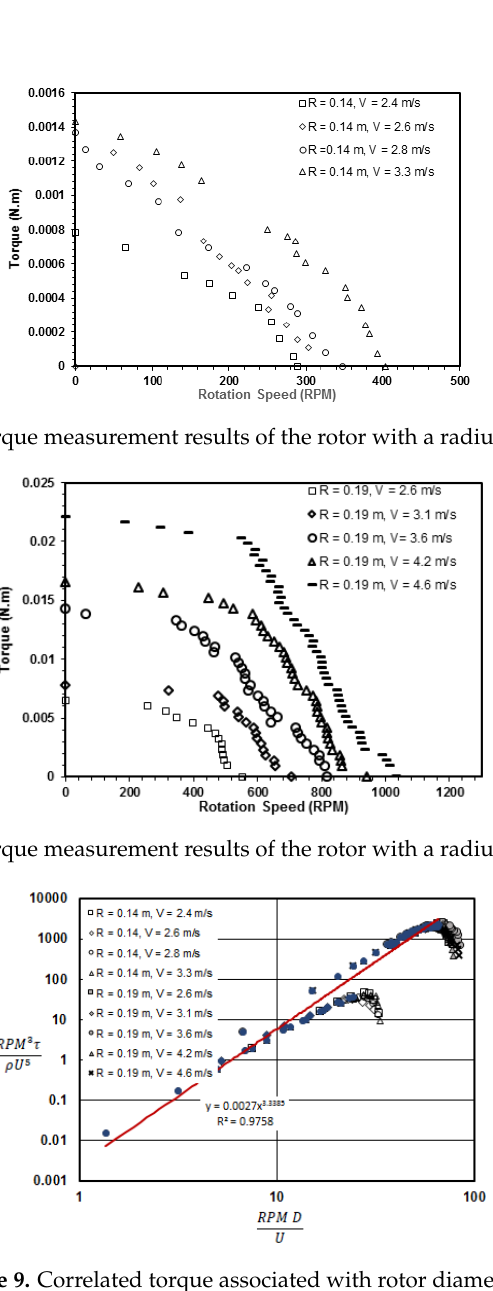
Figure 9. Correlated torque associated with rotor diameters.